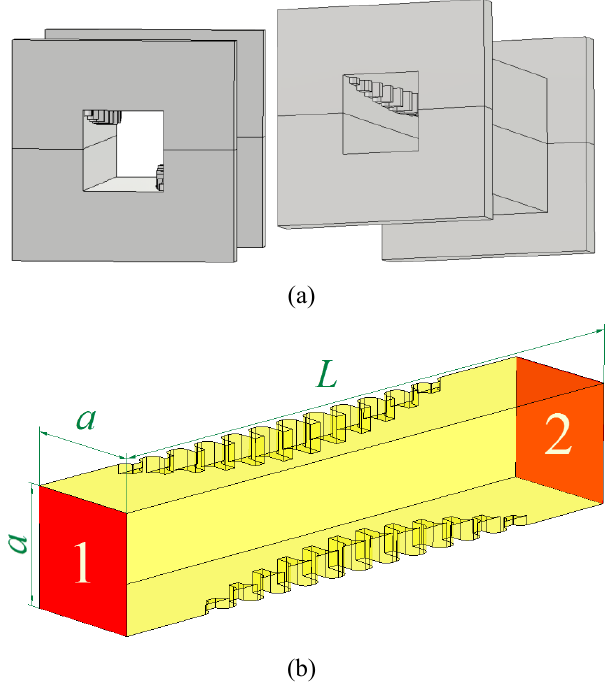
FIGURE 1. External view (a) and inner structure (b) of the developed square waveguide polarizer with diagonally located